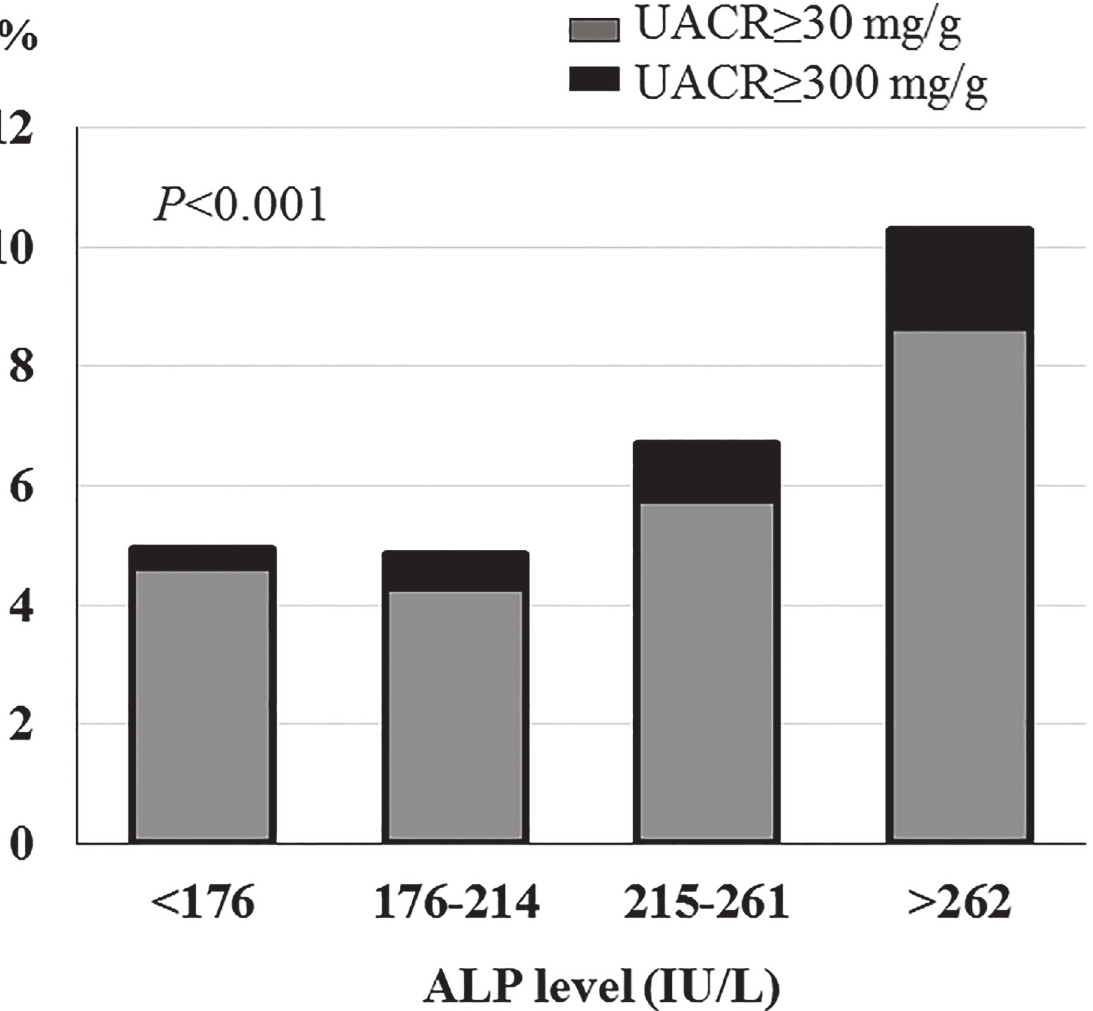
Fig 1. Associations of albuminuria among serum alkaline phosphatase quartiles in participants with eGFR (cid:1) 60 ml/min/1.73m 2 .